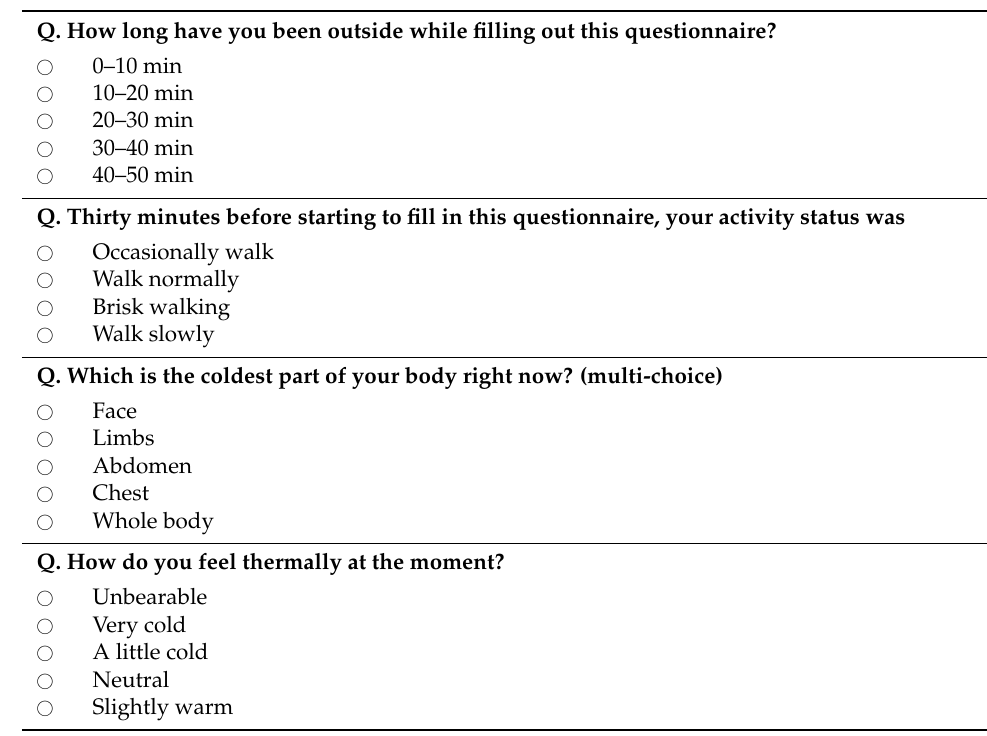
Table A2. Questionnaire